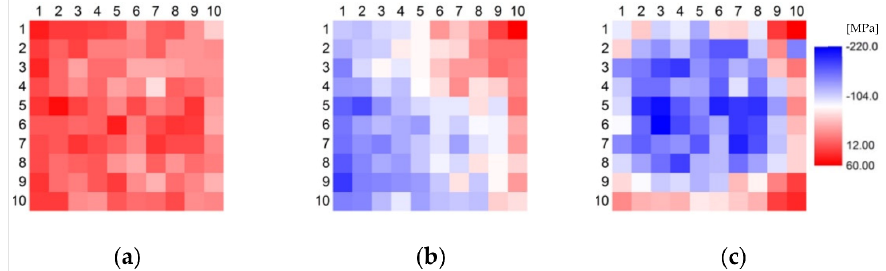
Figure 13. Stress distribution at 180 ◦ C, on Si_Unmounted chip ( a ), A_AuSn_p sample ( b ), and A_AuSn sample ( c